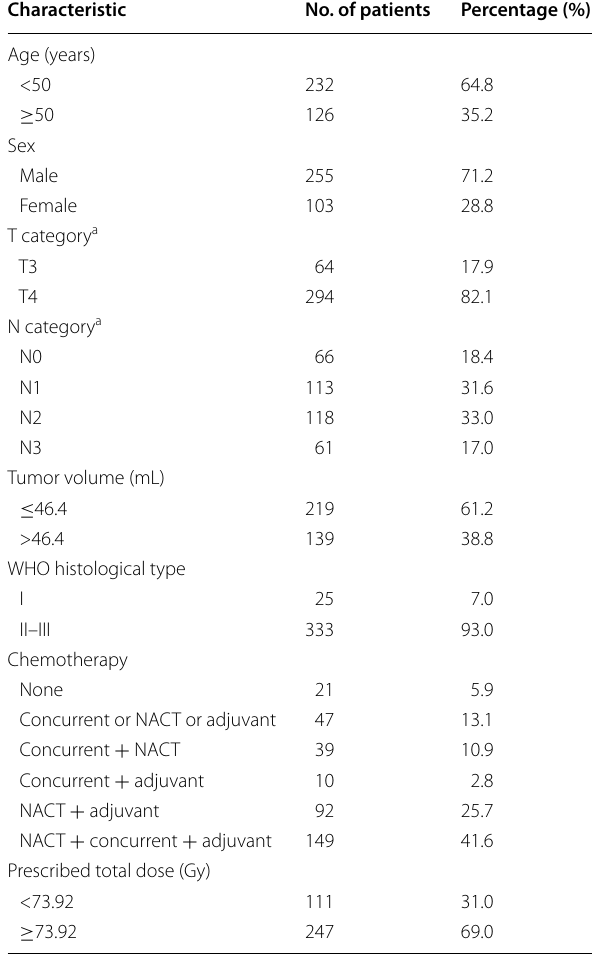
WHO World Health Organization, NACT neoadjuvant chemotherapy a The 7th American Joint Committee on Cancer (AJCC) staging system was used for T and N classification